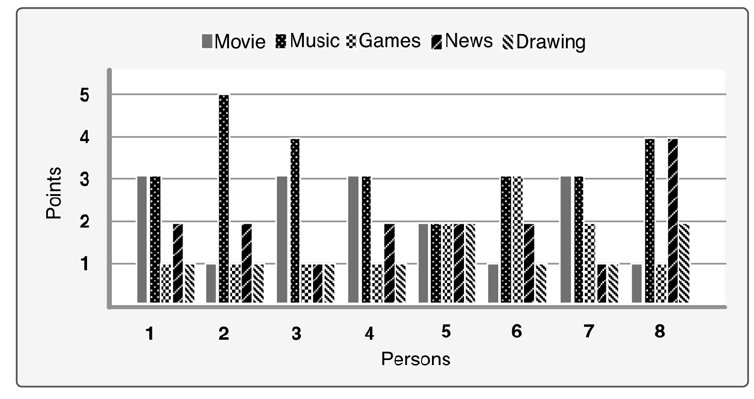
Figure 7. Preferable media for persons.